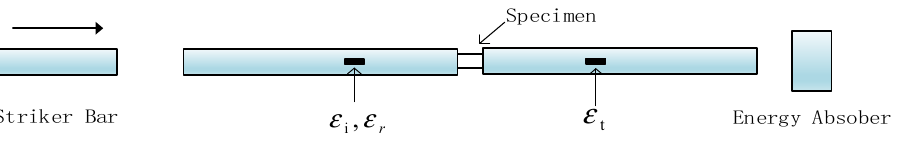
Figure 5. Layout of the Hopkinson compressive bar system.